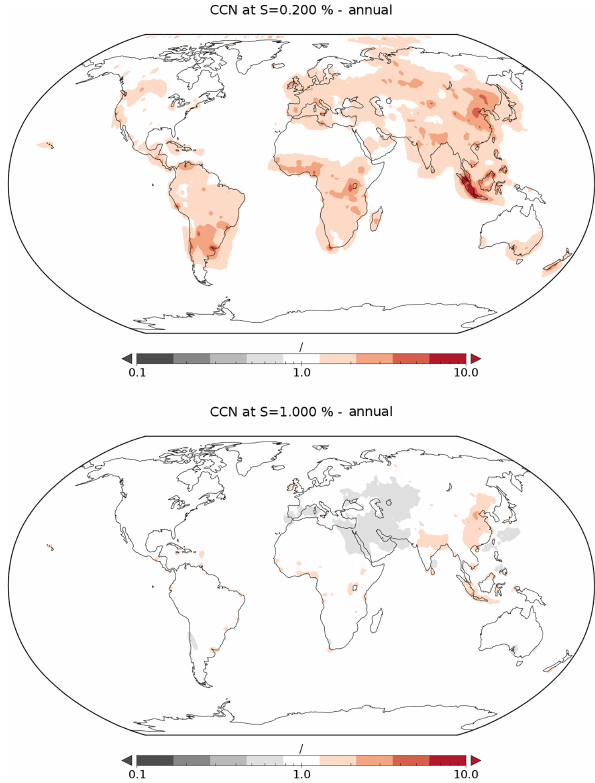
Figure 7. Modeled annual GAINS / AeroCom ratios of CCN0.2 and CCN1.0 at surface level.